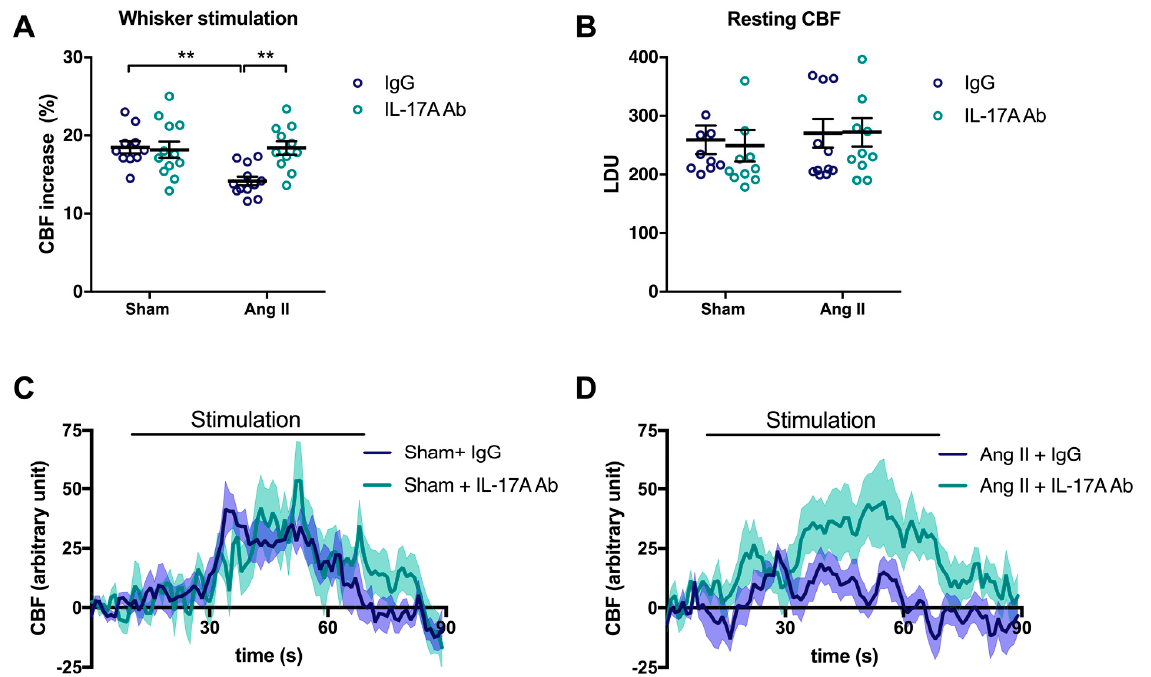
Figure 1. IL-17A neutralization prevents neurovascular coupling impairment induced by Ang II. Cerebral blood flow (CBF) in response to whiskers stimulations measured in vivo by laser Doppler flowmetry in C57BL/6 male mice treated with an anti-IL-17A neutralizing antibody (IL-17A Ab) or control mouse immunoglobulin G (IgG) antibody (0.5 μ g/ μ L per mouse every 4 days, i.p.). This administration started at day 0 of Ang II (600 ng/kg/min, 14 days) infusion through an osmotic minipump or sham surgery. The graphs depict ( A ) CBF as percentage changes with respect to the initial CBF value, ( B ) resting CBF value as laser Doppler perfusion units (LDU), and ( C , D ) 1 s average curves of the evoked CBF, expressed in arbitrary unit. SEM is represented by the lighter tone shade surrounding each curve. Data were analyzed using an ANOVA for factorial design followed by a Bonferroni post-test. ** p < 0.01 and n = 10–12 per group. To assess whether IL-17A impairs NVC through its receptor, mice received an IL-17A receptor antagonist (IL-17RA mAB) simultaneously with the chronic systemic administra- tion of Ang II. In this experimental group, CBF increased in response to whiskers stimu- lations by 13.6% ± 0.6 and 18.3 ± 0.6% in the presence or the absence of Ang II, respectively (Figure 2A; p < 0.01). Inhibiting IL-17RA prevented the NVC attenuation induced by Ang II (Figure 2A,D; p < 0.01) without modifying the relative resting CBF (Figure 2B). Never- theless, inhibition of the IL-17A receptor attenuated the increased SBP induced by Ang II by 8.2 ± 4.7 and 7.9 ± 2.6 mmHg on days 7 and 14, respectively (Supplemental Figure S2). In control mice, the IL-17RA mAB did not elicit changes in cerebrovascular responses (Fig- ure 2A–C) or SBP (Supplemental Figure S2).